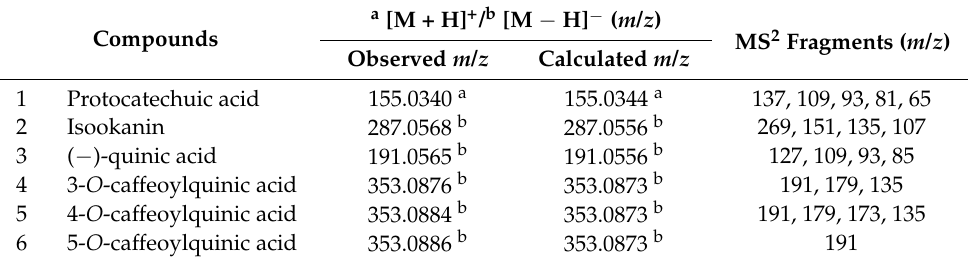
Table 1. HR-ESI MS/MS data for compounds isolated in the aqueous extract of B. pilosa . Triple TOF